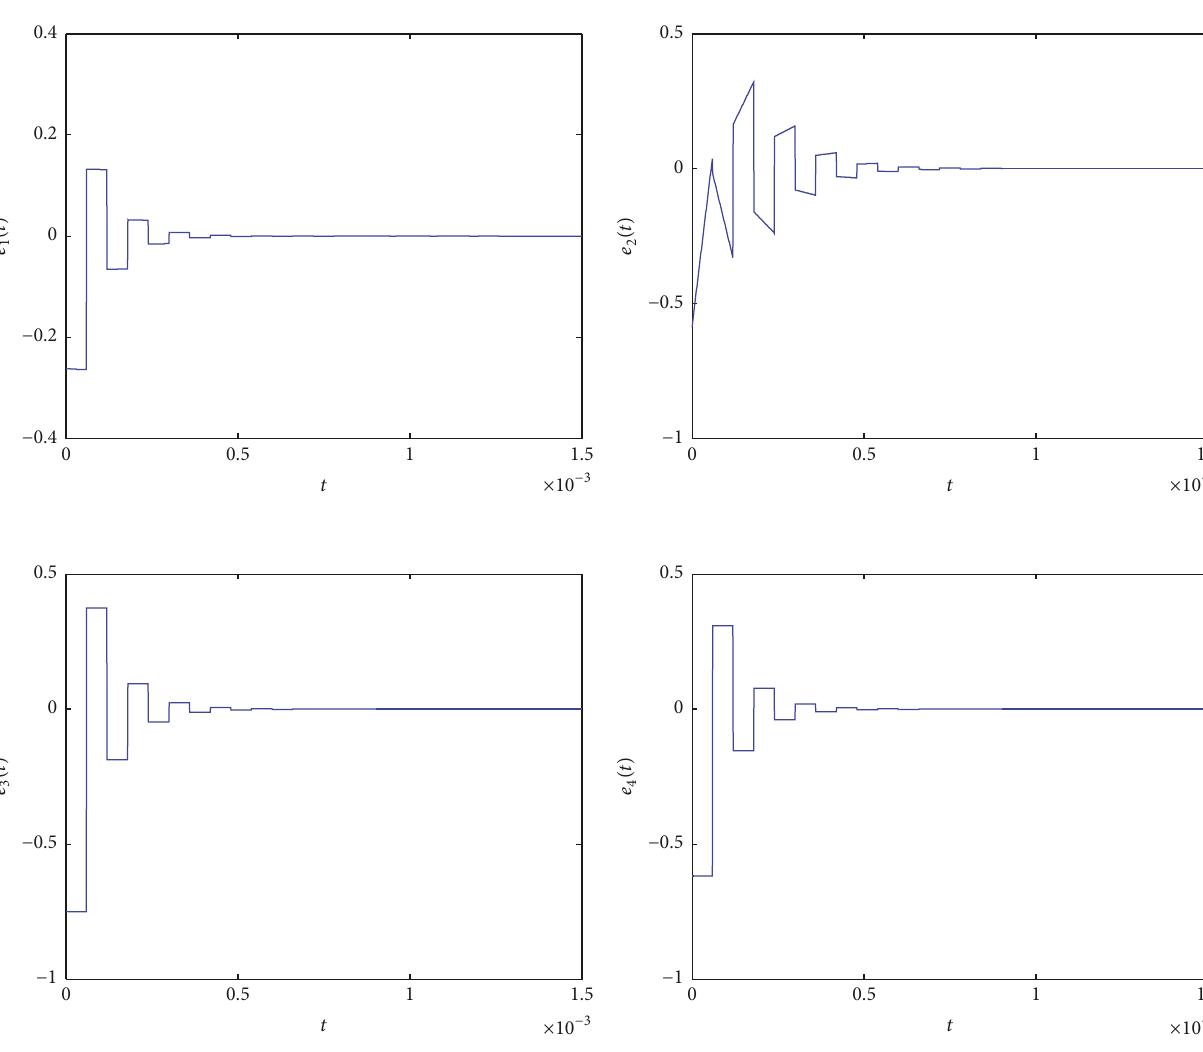
Figure 5: Simulation results of synchronization